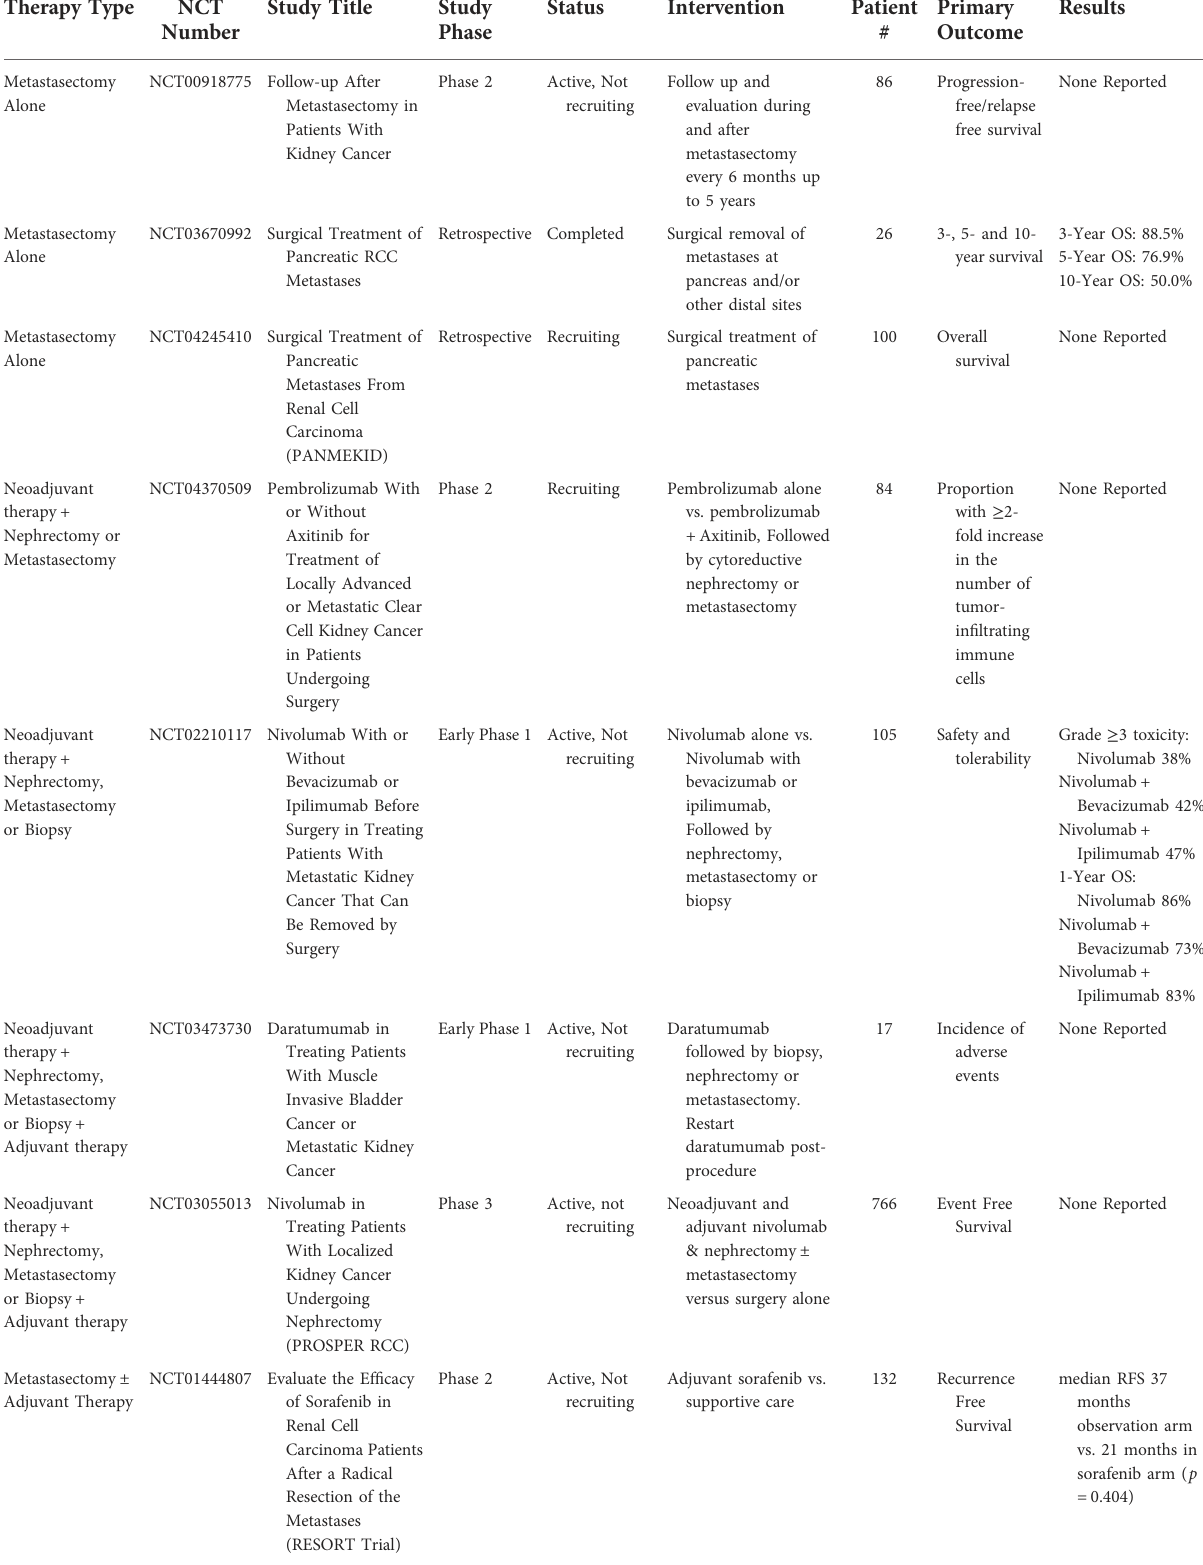
TABLE 6 Completed and ongoing clinical trials including patients undergoing metastasectomy for metastatic renal cell